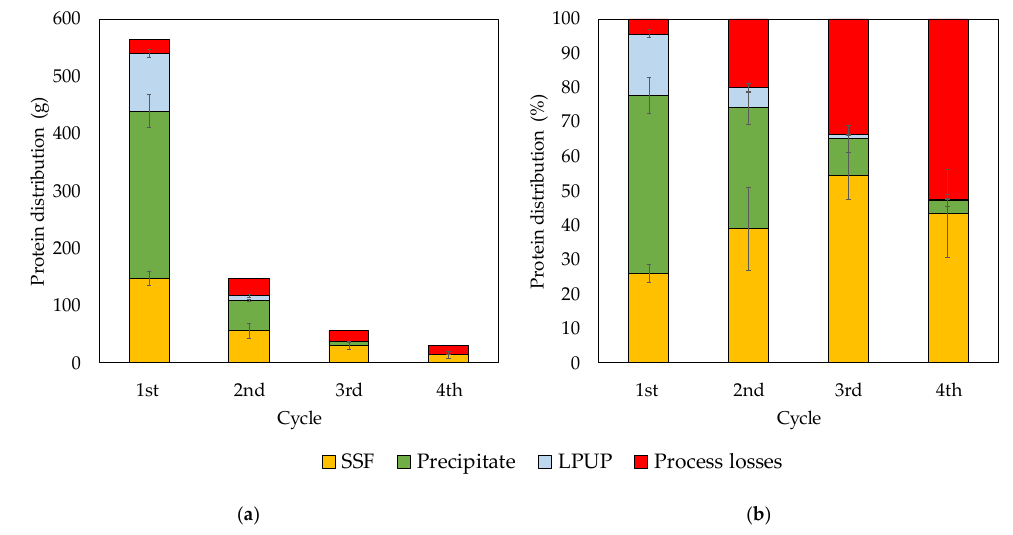
Figure 4. Protein distribution in the various process streams for each recirculation cycle. ( a ) Protein expressed on mass basis. ( b ) Protein expressed as % within each recirculation cycle. SSF= spent solids fraction and LPUP= light phase with unprecipitated protein.